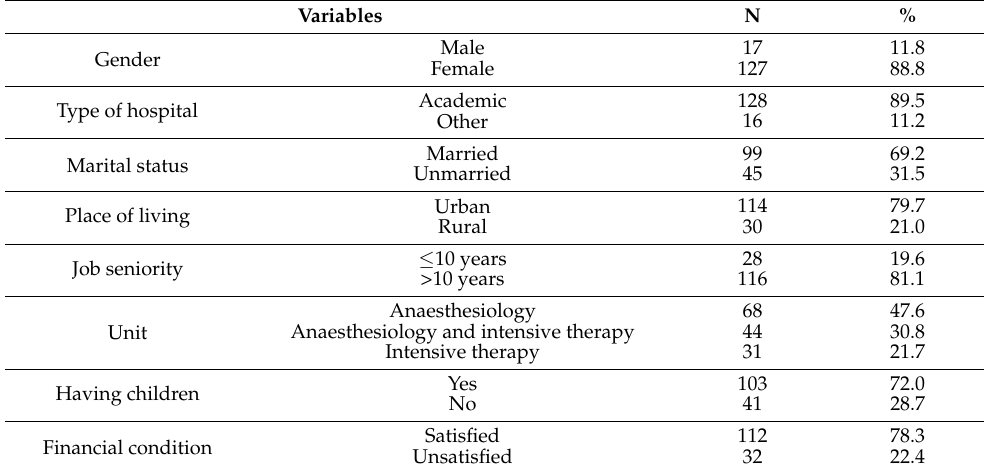
Table 1. Group characteristics ( n =